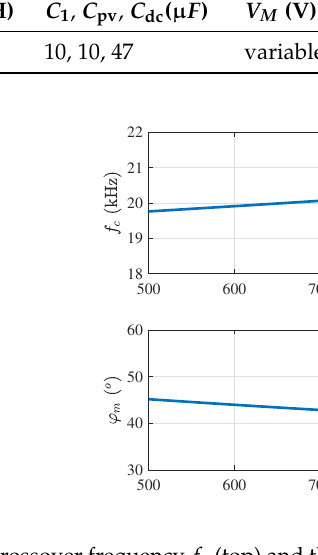
Figure 7. The crossover frequency f c (top) and the phase margin ϕ m (bottom) of the small-signal model of the quadratic boost converter with the input voltage control for different values of the irradiance S between 500 W/m 2 ( P max 42 W) and 1000 W/m 2 ( P max 85 W). V M = 4 V. Θ = 25 ◦ ≈ ≈